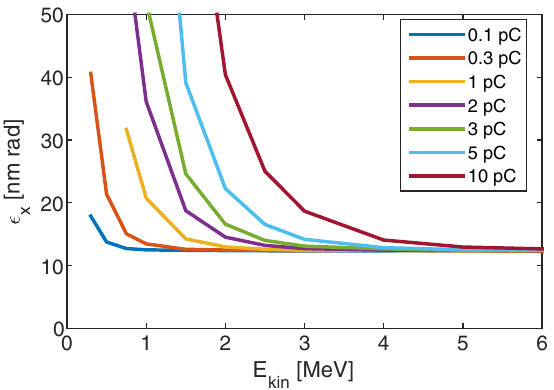
FIG. 6. Space charge effects on the reconstruction of the horizontal emittance of a geometric phase space distribution in different energy and charge scenarios.